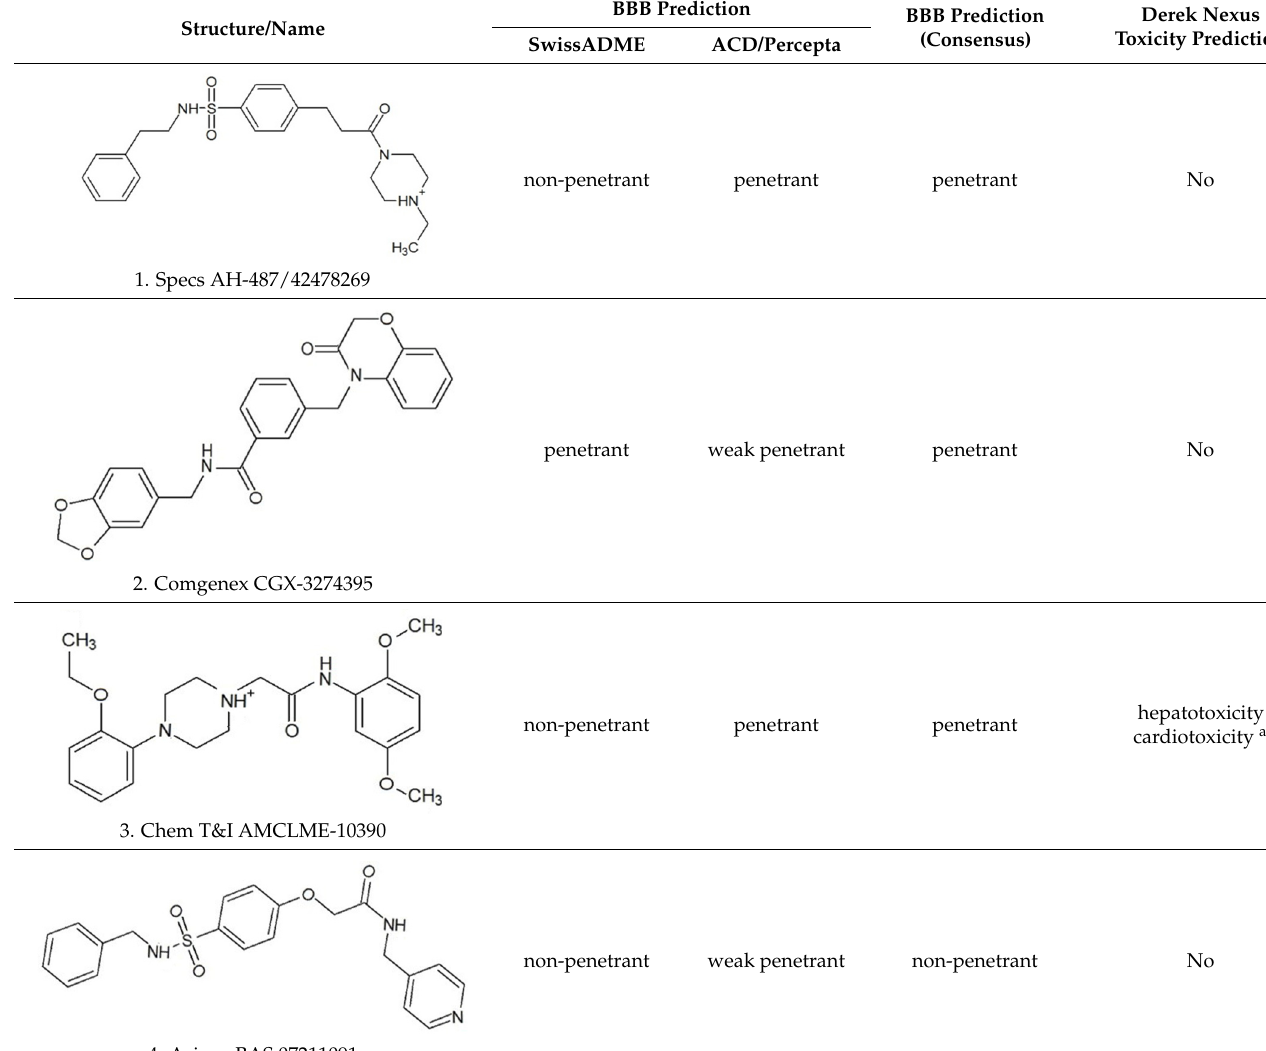
Table 4. BBB penetration and toxicity predictions for the hits identified in the virtual screening.